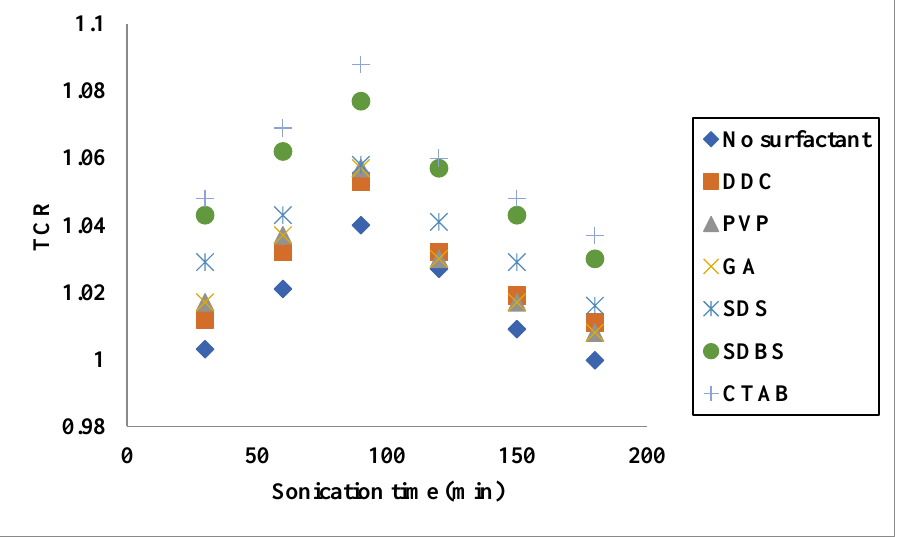
Figure 3. Effects of surfactant and sonication time on TCR of CeO 2 -MWCNT/water (SMR: surfactant mixing ratio = 3:2, φ = 0.75%, T = 30 °C). Adapted from Ref. [42].